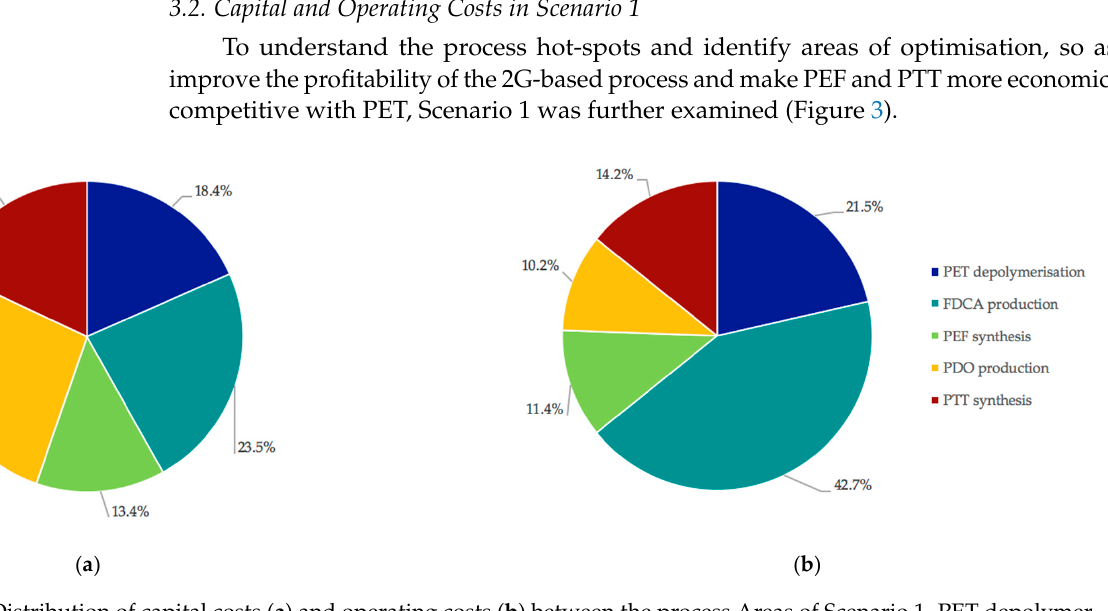
Figure 3. Distribution of capital costs ( a ) and operating costs ( b ) between the process Areas of Scenario 1. PET depolymer- ization = Area 1; FDCA production = Area 2; PEF synthesis = Area 3; PDO production = Area 4; PTT synthesis = Area 5.